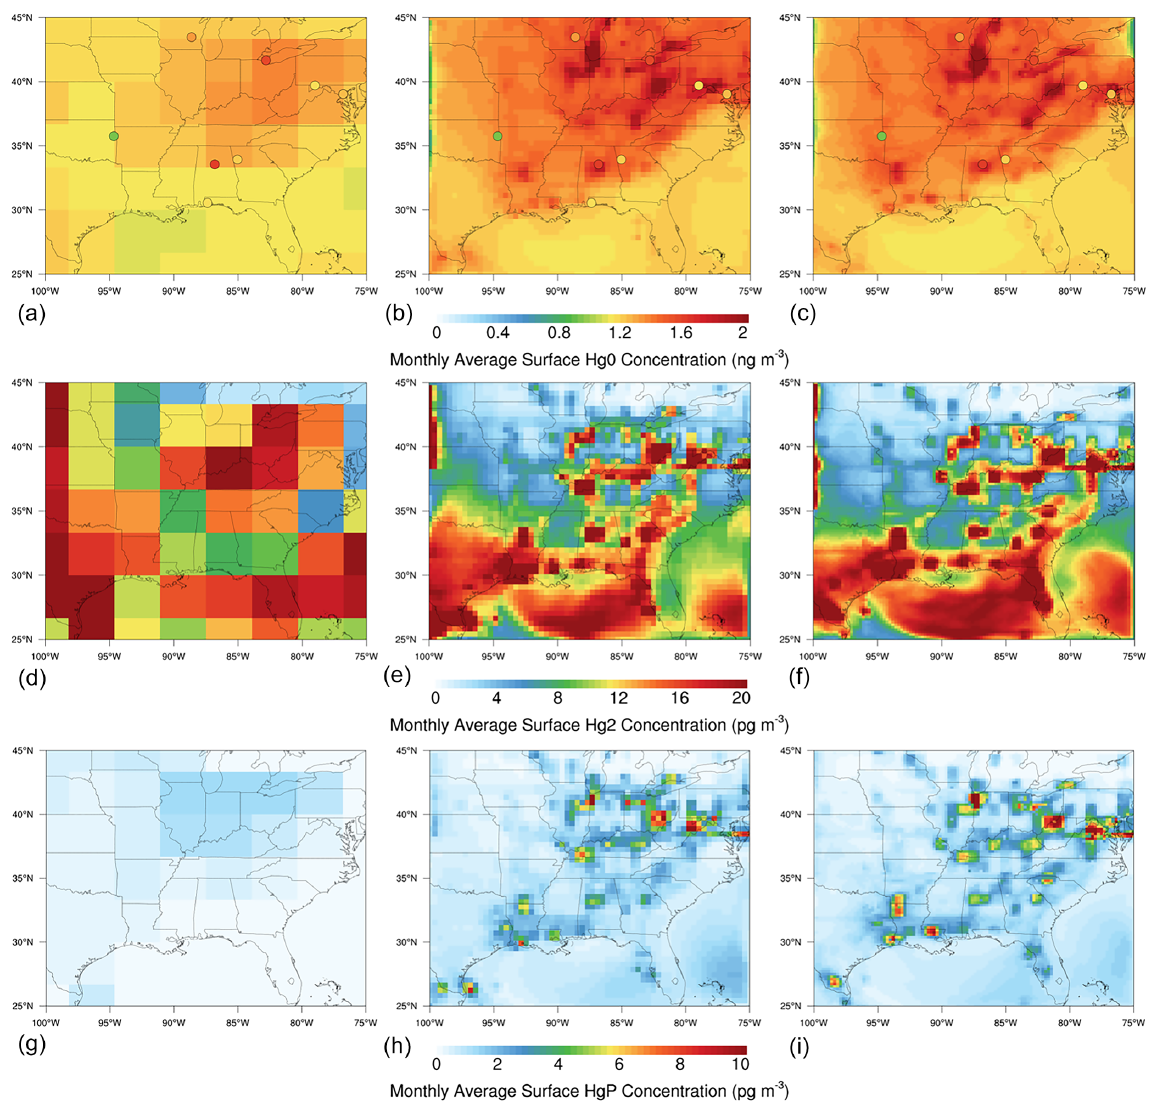
Figure 4. Comparison of monthly average Hg surface concentration of Hg 0 (a, b, c) , Hg 2 (d, e, f) , and HgP (g, h, i) from July to Septem- ber 2013. Panels (a, d, g) show the GEOS-Chem 4 ◦ × 5 ◦ simulation. Panels (b, e, h) – (c, f, i) correspond to different WRF-GC resolutions: 50km × 50km and 25km × 25km. Dots in (a–c) represent Hg 0 observation data from AMNet of NADP (http://nadp.slh.wisc.edu/AMNet/, last access: 16 March